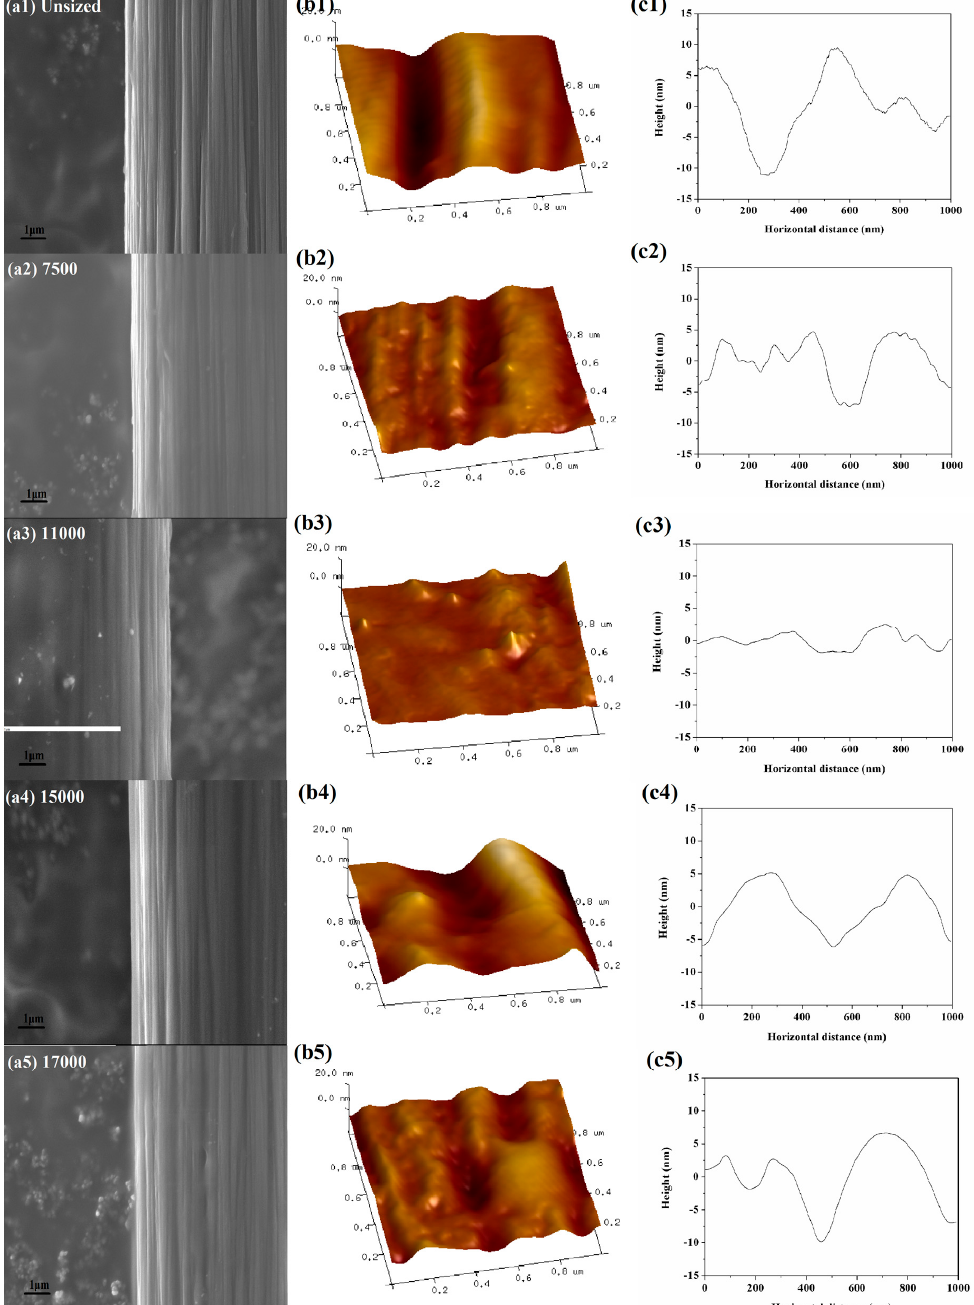
Figure 10. Surface morphology of CFs: ( a1 – a5 ) surface morphology by SEM of unsize CFs ( a1 ) and sized CFs by emulsions of 7500 ( a2 ), 11,000 ( a3 ), 15,000 ( a4 ) and 17,000 ( a5 ); ( b1 – b5 ) 3D height images by AFM of unsize CFs ( b1 ) and sized CFs by emulsions of 7500 ( b2 ), 11,000 ( b3 ), 15,000 ( b4 ) and 17,000 ( b5 ); and ( c1 – c5 ) height profiles derived from ( b1 – b5 ).